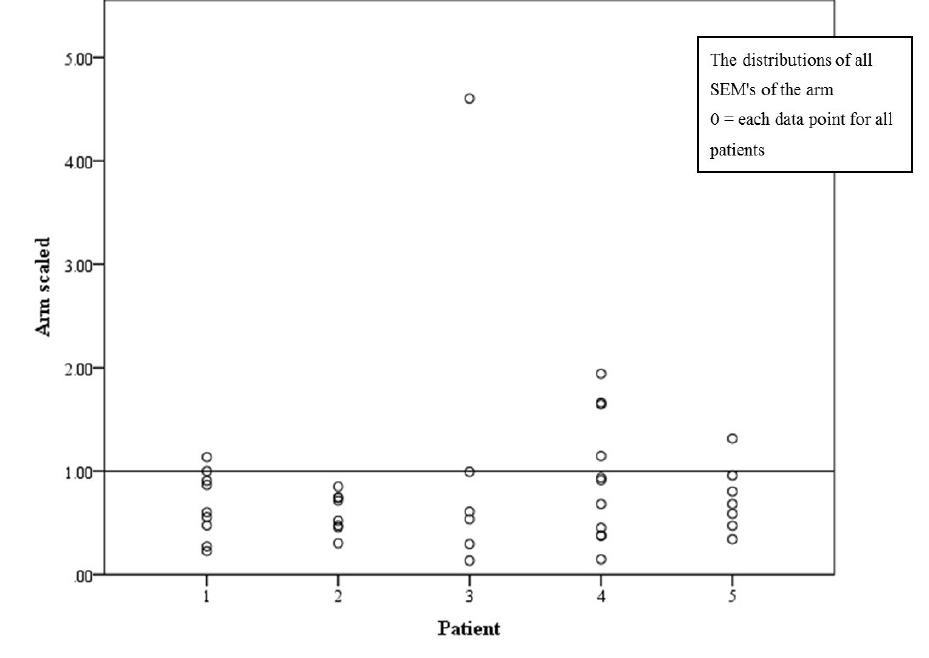
Figure 1. SEM in mL for 41 PTs measuring an arm; each symbol represents a patient.